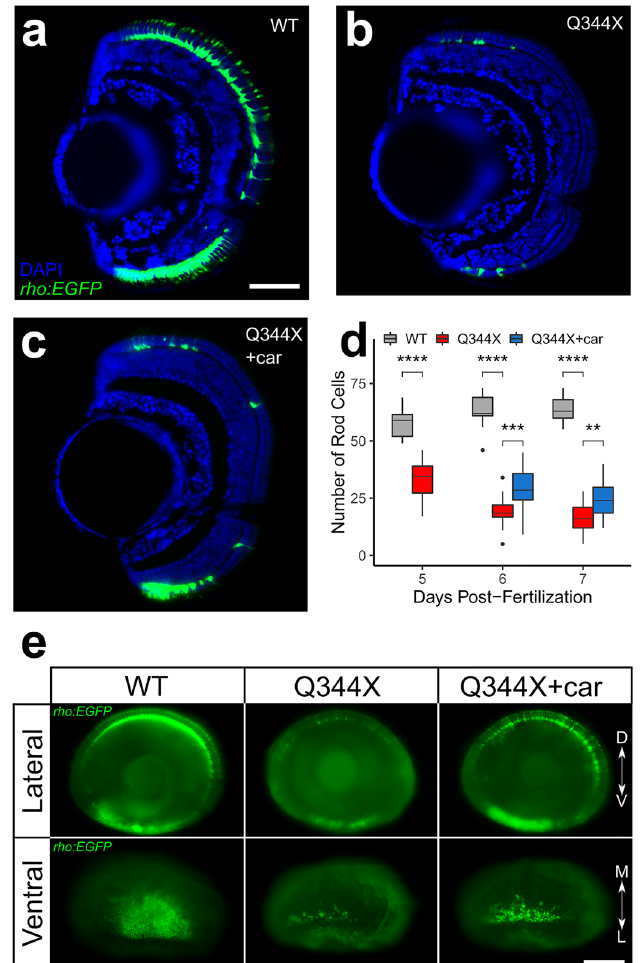
Figure 3. Carvedilol treatment increased rod numbers in the Q344X larvae. Representative retinal cryosection of ( a ) a wildtype larva (WT), ( b ) a DMSO-treated Q344X larva, and ( c ) a carvedilol-treated Q344X (car) larva at 7 dpf. Rods were labeled by EGFP expression driven by rho promoter, and the nuclei were counterstained with DAPI. Scale = 50 μm. ( d ) Quantification of rod number in WT, DMSO-treated Q344X, and carvedilol- treated Q344X retinal cryosections from 5 to 7 dpf. There was a statistically significant difference in rod number between groups at all stages determined by one-way ANOVA at 5 dpf (WT, N = 11; Q344X, N = 16; F (1,25) = 71.04, p value < 0.0001), at 6 dpf (WT, N = 9; Q344X, N = 20; Q344X + car, N = 21 ; F (2,44) = 96.9, p value < 0.0001), and at 7 dpf (WT, N = 9; Q344X, N = 17; Q344X + car, N = 11; F (2,41) = 167.9, p value < 0.0001). The effect of Q344X rod degeneration and carvedilol treatment on rod number was assessed post hoc by pairwise t-test with false discovery rate correction at 6 dpf (WT − Q344X, p value < 0.0001; Q344X − Q344X + car, p value < 0.001) and at 7 dpf (WT − Q344X, p value < 0.0001; Q344X − Q344X + car, p value < 0.001). ( e ) Representative whole-eye images of WT, Q344X, and carvedilol-treated Q344X larvae at 7 dpf. Rods were labeled by EGFP expression. Left column: WT rods were mainly found on dorsal and ventral retina (top). They were abundantly present in the ventral patch of the retina extending medially (bottom). Middle column: Q344X rods were mostly degenerated at the same stage (top). There were only a handful of rods remaining near the lateral edge of the ventral patch in the Q344X retina (bottom). Right column: carvedilol treatment increased the number of Q344X rods on both dorsal and ventral retina (top); however, gaps of missing rods were still apparently on dorsal retina. More rods were observed in the ventral patch of the carvedilol-treated retina (bottom). Statistical analysis of whole-mount data is shown in Table 2. Scale = 100 μm. D dorsal, V ventral, M medial, L